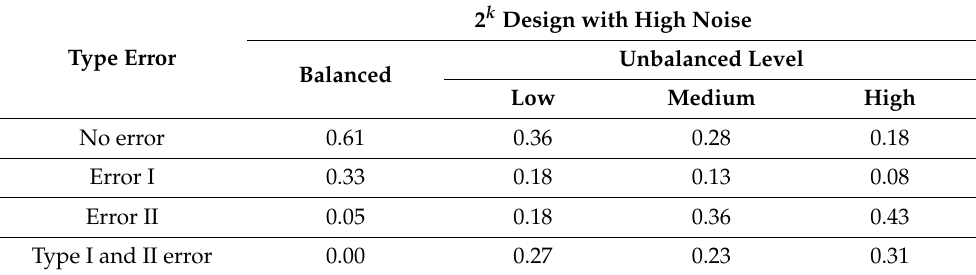
Table 13. Values for different levels of unbalance with high noise.